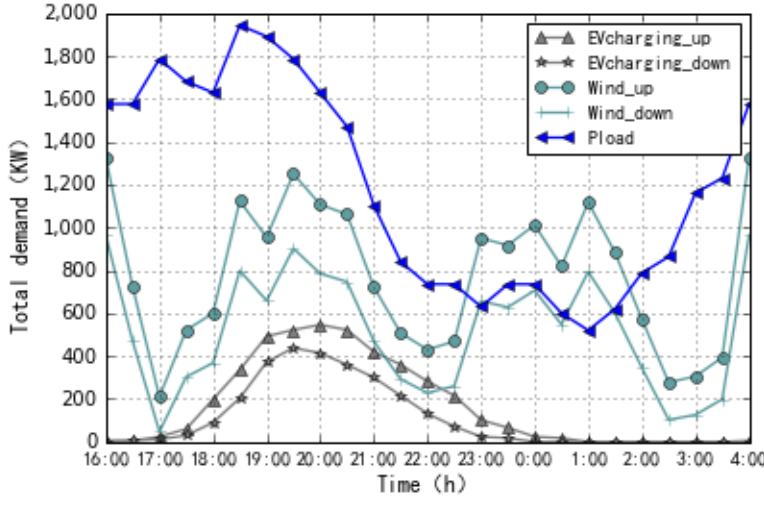
Figure 3. Initial status of a microgrid.